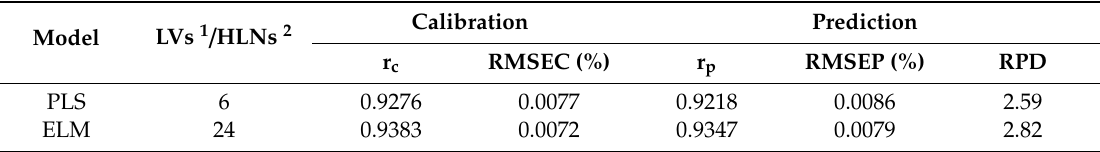
Table 2. The performances of the partial least squares (PLS) model and the extreme learning machine (ELM) model with full spectra.